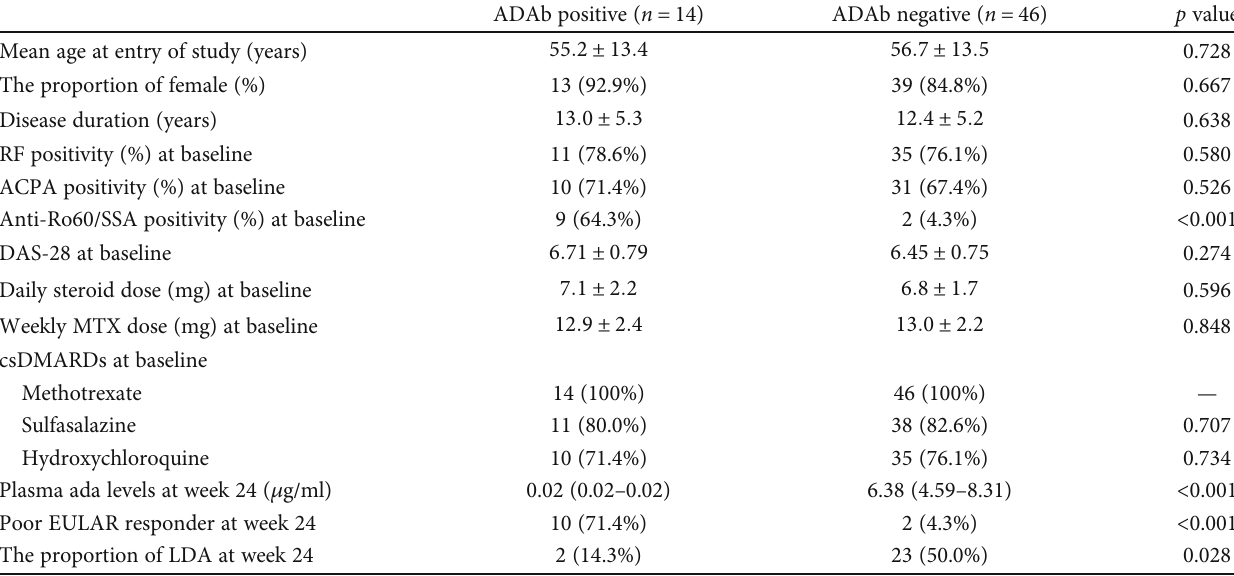
Table 1: Clinical characteristics of RA patients with and without ADAb in the combined Cohort-1 and Cohort-3 (Hospital A) a